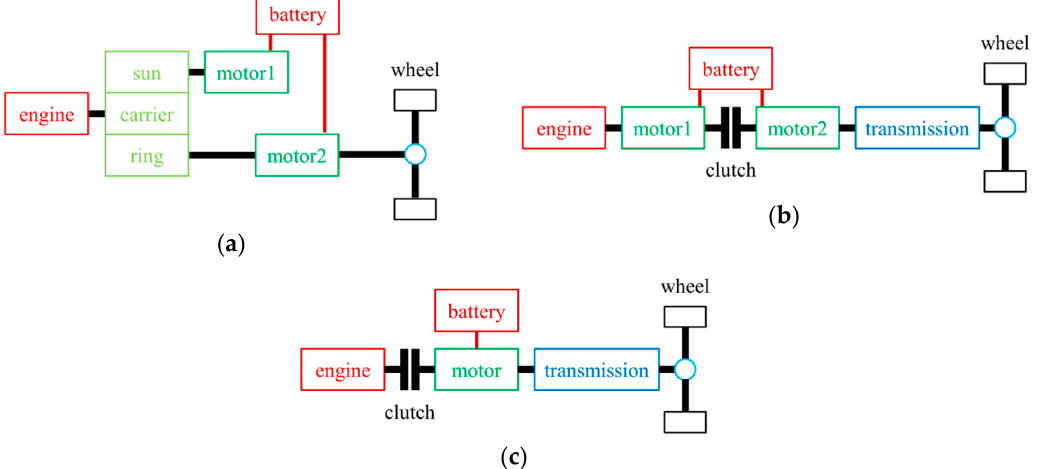
Figure 1. Typical hybrid powertrain architectures. ( a ) Typical planetary gear set based series ‐ parallel hybrid powertrain configuration; ( b ) Typical clutch ‐ based series ‐ parallel hybrid powertrain configuration; ( c ) clutch ‐ based pre ‐ transmission parallel hybrid powertrain (CPPHP) configuration.